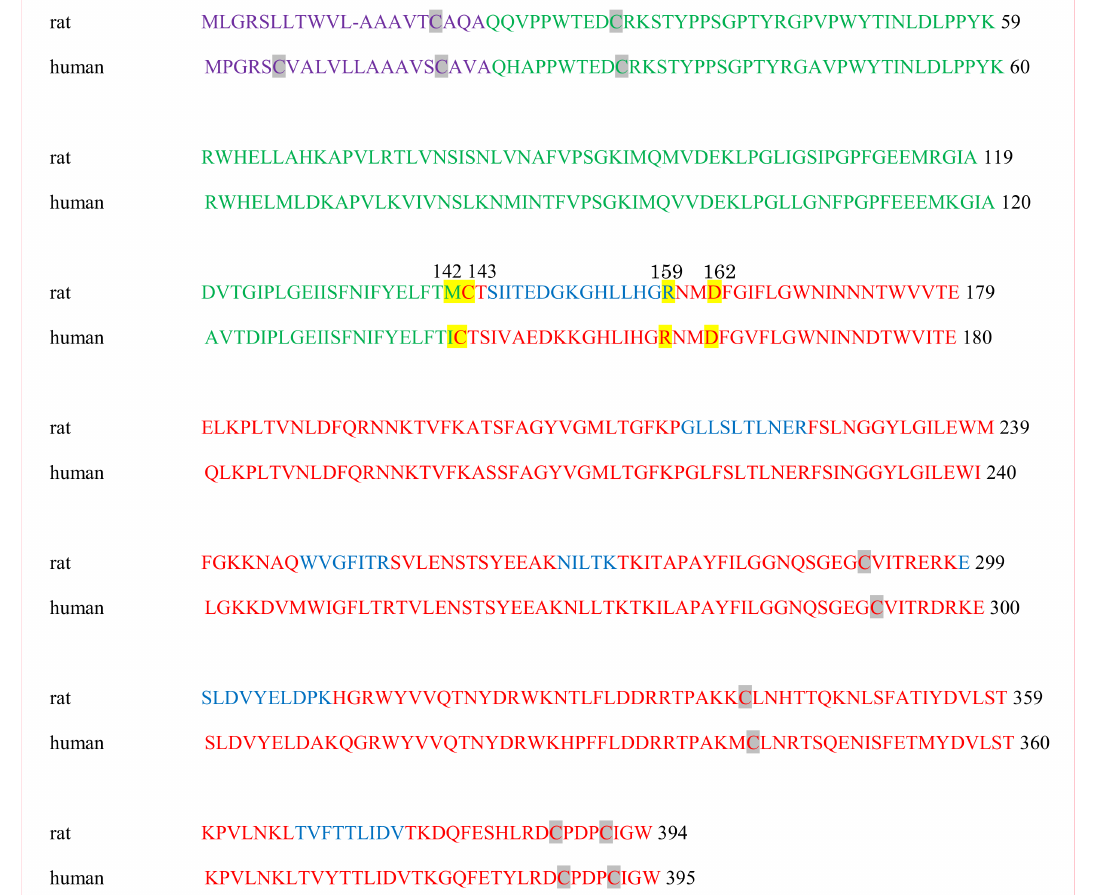
Table 2. aCDase β -subunit hits by MASCOT database.